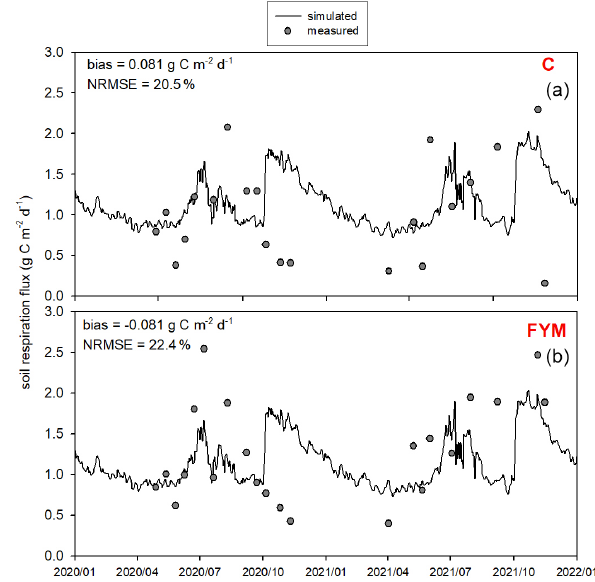
Figure 13. Comparison of the simulated and observed soil respira- tion flux for two treatments: absolute control ( C; a) and application of farmyard manure ( FYM; b) between January 2020 and December 2021 at Martonvásár. Whiskers indicate the uncertainty ( ± 1 stan- dard deviation) of the